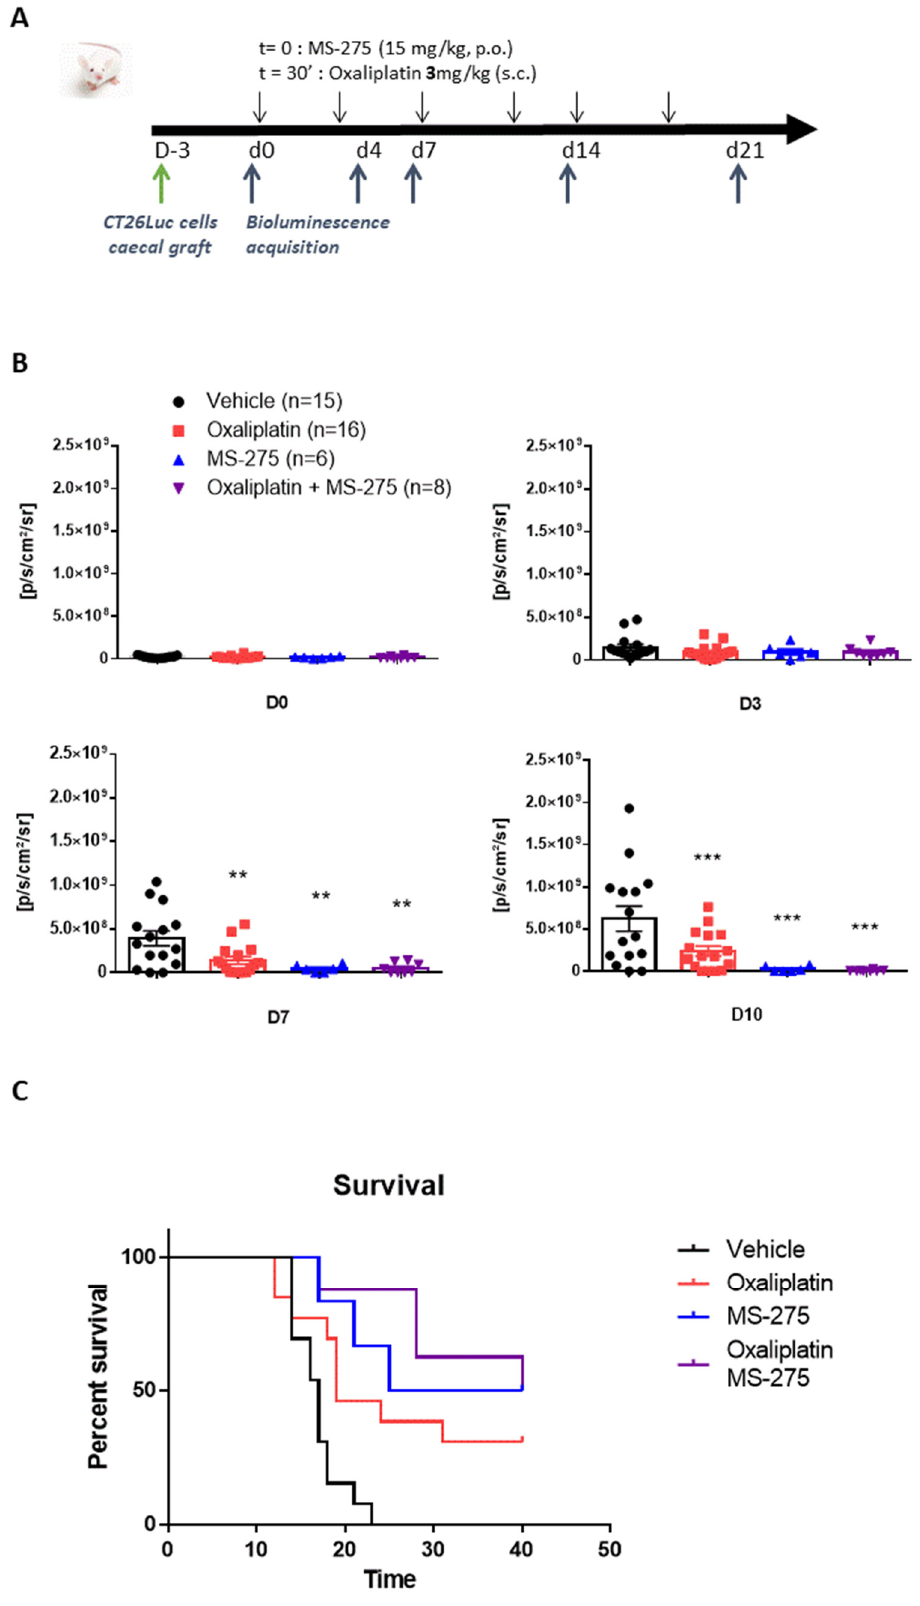
Figure 4. Oxaliplatin and MS-275 exert synergic antitumoral effect in a mouse model of orthotopic CRC. ( A ) Experimental design: BALB/c AnN mice, randomized for treatment, were treated 3 days after graft with oxaliplatin (3 mg/kg i.p.) and/or MS-275 (15 mg/kg, p.o.), twice a week for three